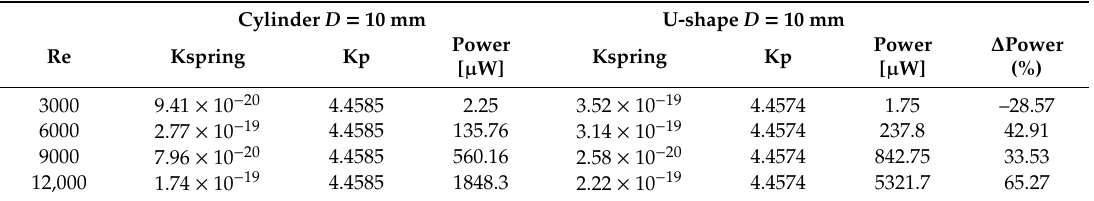
Table 4. Results of the JADE optimization algorithm for the cylinder and U-shaped oscillating bodies with D = 10 mm.